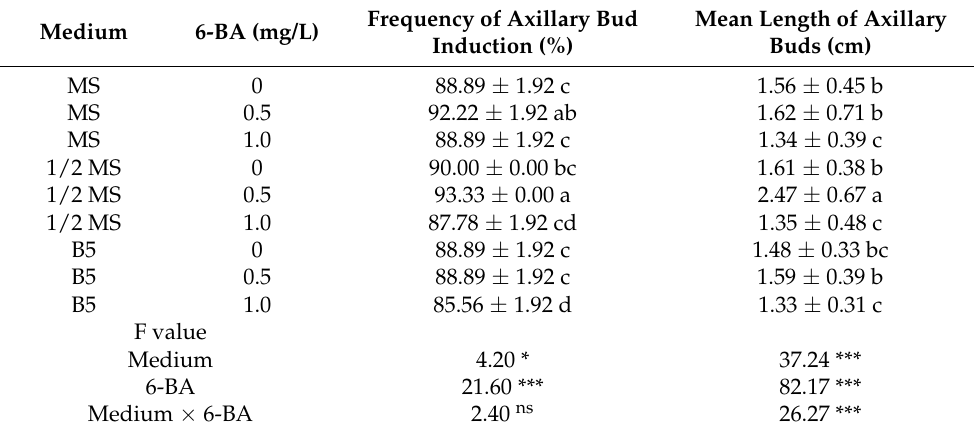
Table 5. Effect of medium types and 6-BA on axillary bud